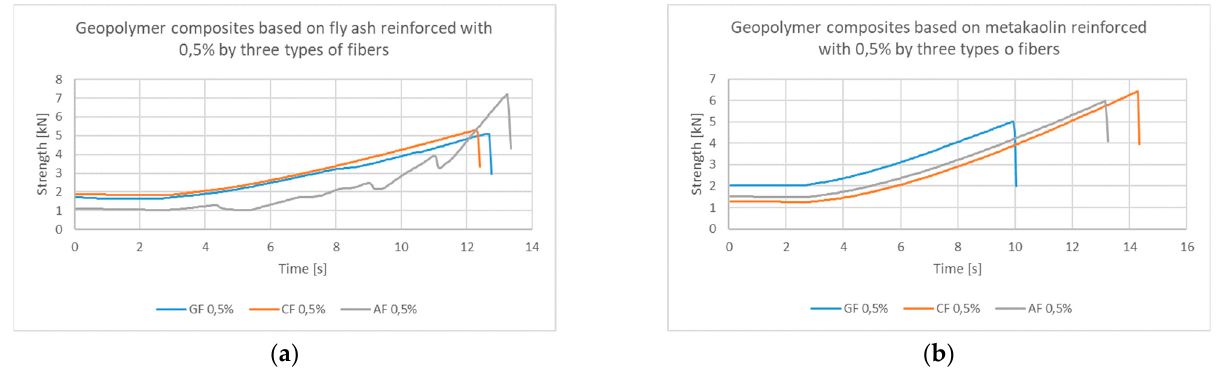
Figure 5. Strength–time comparison of the behavior of composites based on: ( a ) fly ash, ( b ) metakaolin, with the addition of 0.5% roving from glass fiber, carbon fiber, aramid